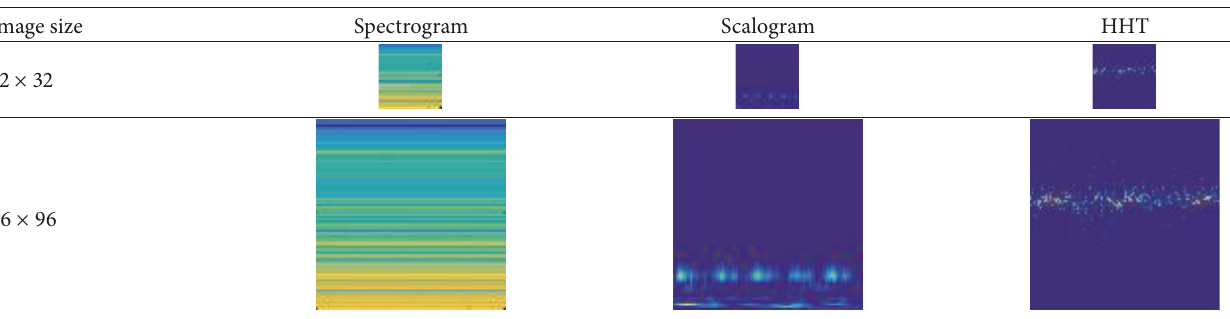
Figure 8: Test stand for roller bearing accelerometer data. Table 14: CWR baseline